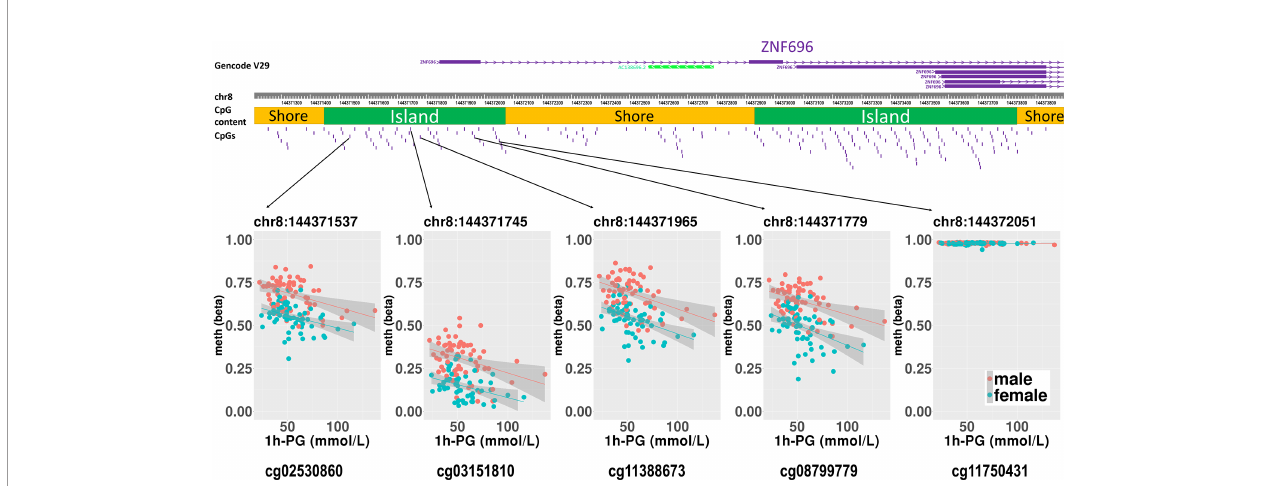
FIGURE 2 | Rlm analysis of DNA methylation and 1-h PG after birth in each of fi ve CpG sites located in the same CpG island in the ZNF696 promoter. DNA methylation of the 5 ′ region of four CpG sites was associated with PG at 1 h after birth after birth. Only cg11388673 and cg08799779 were signi fi cant after considering covariates and confounders.